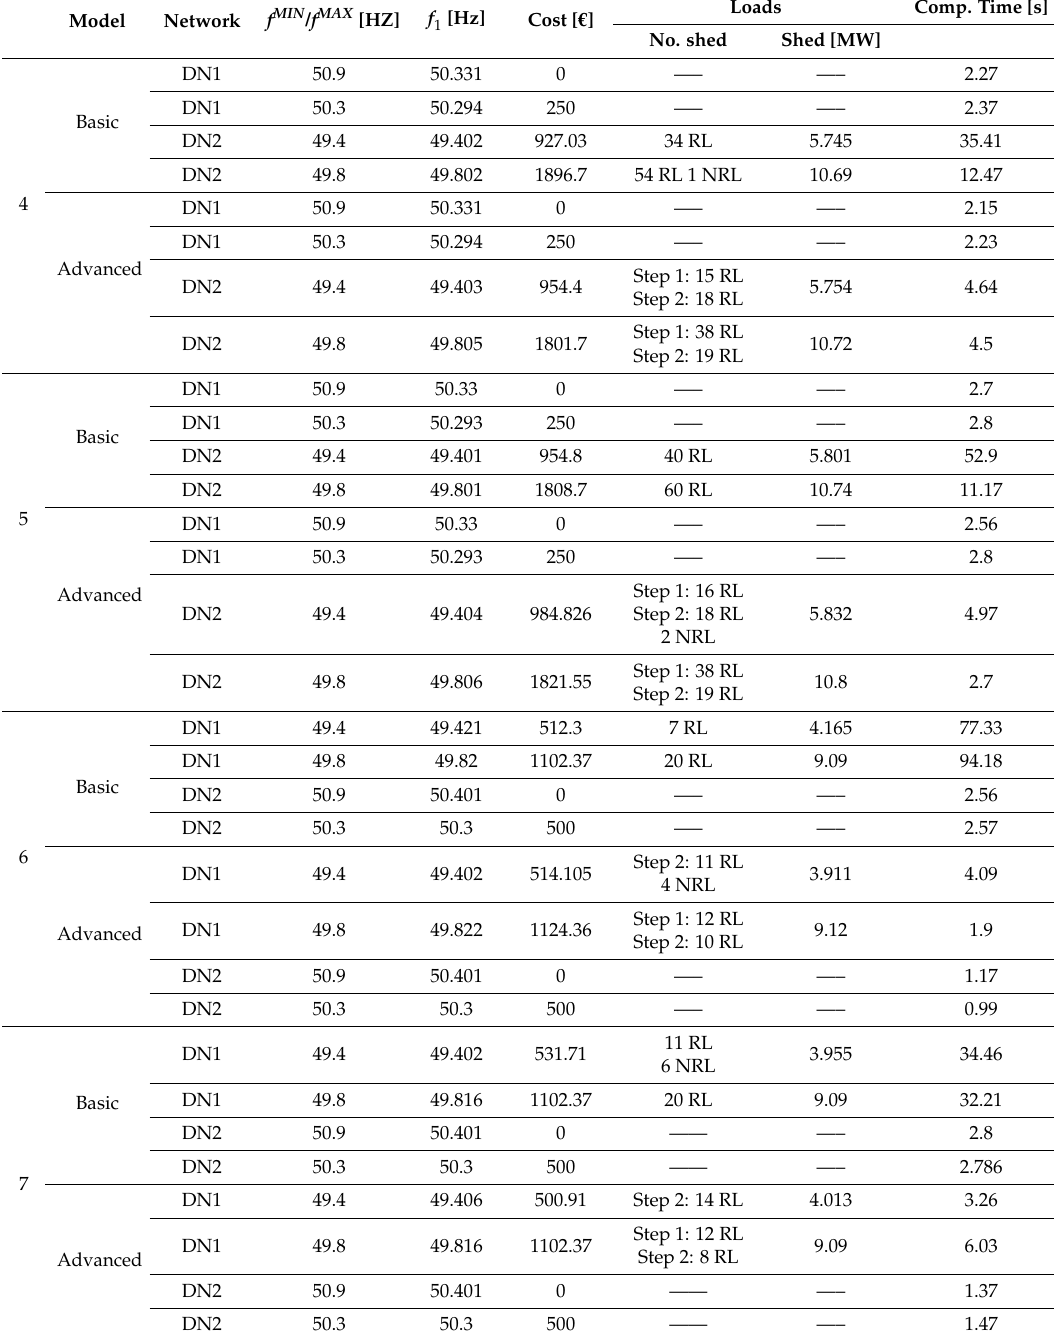
Table 7. Main results of the optimization models: high generation